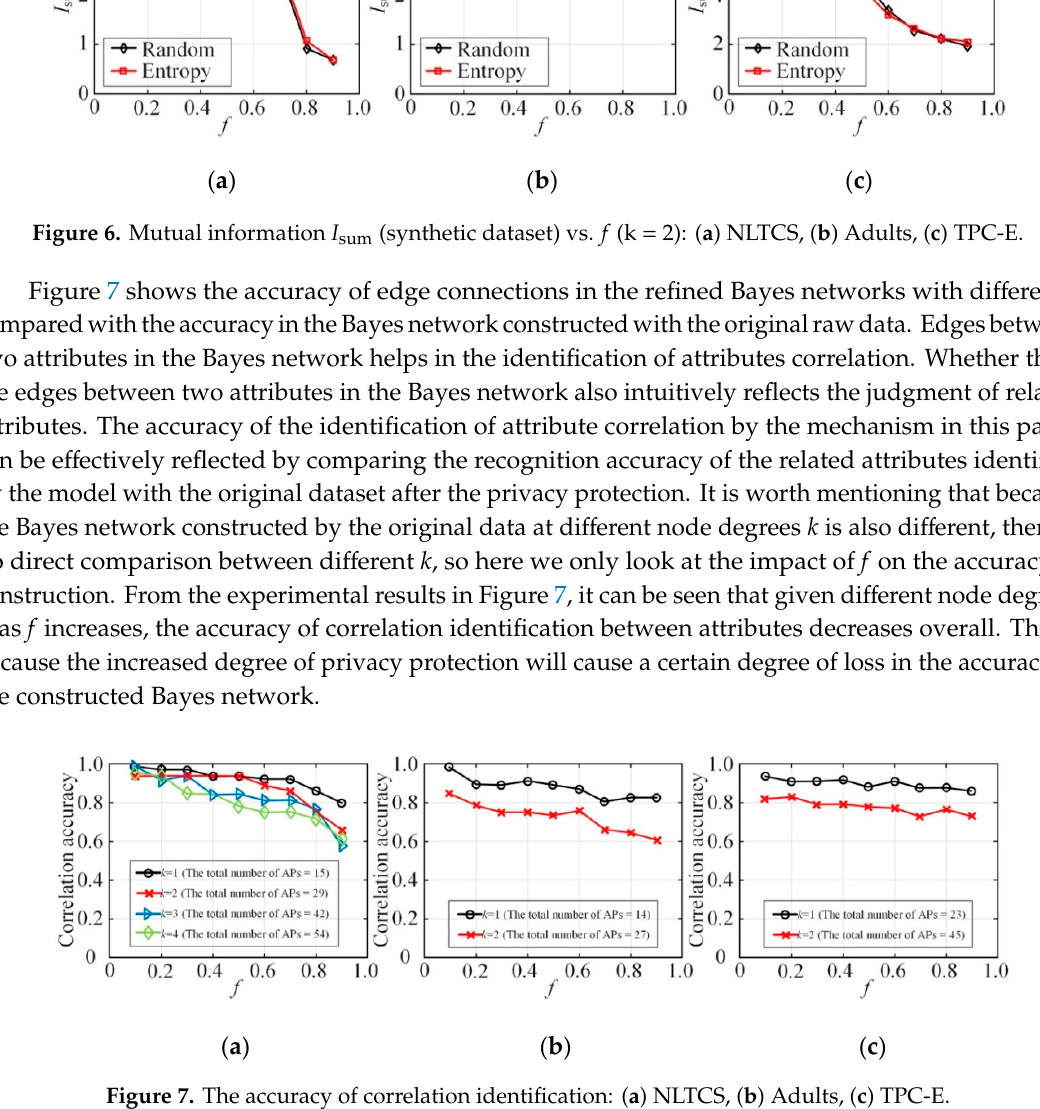
Figure 7. The accuracy of correlation identification: ( a ) NLTCS, ( b ) Adults, ( c ) TPC-E.